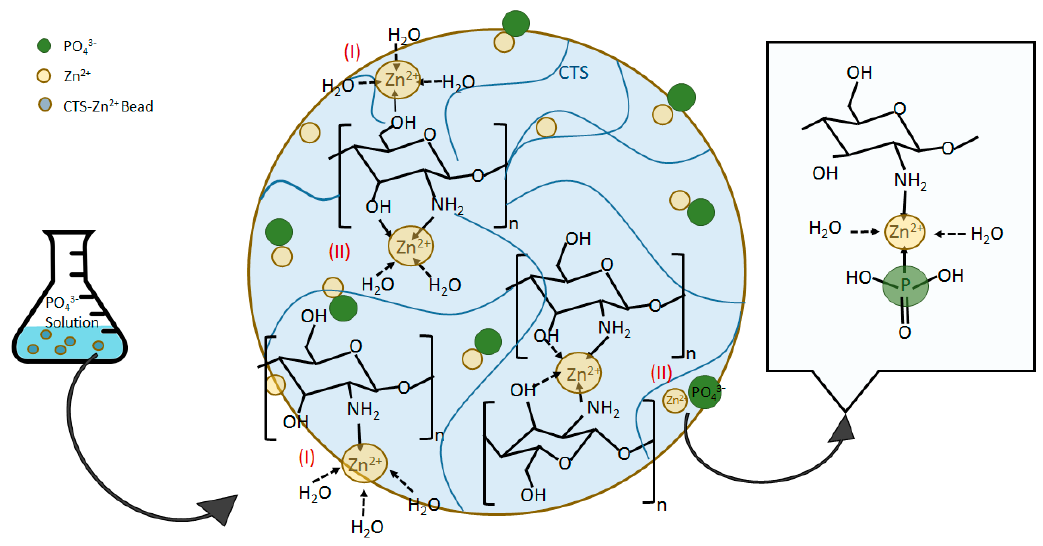
Figure 12. Possible structures of Zn(II)–CTS complexation and corresponding mechanism for phosphate uptake. phosphate